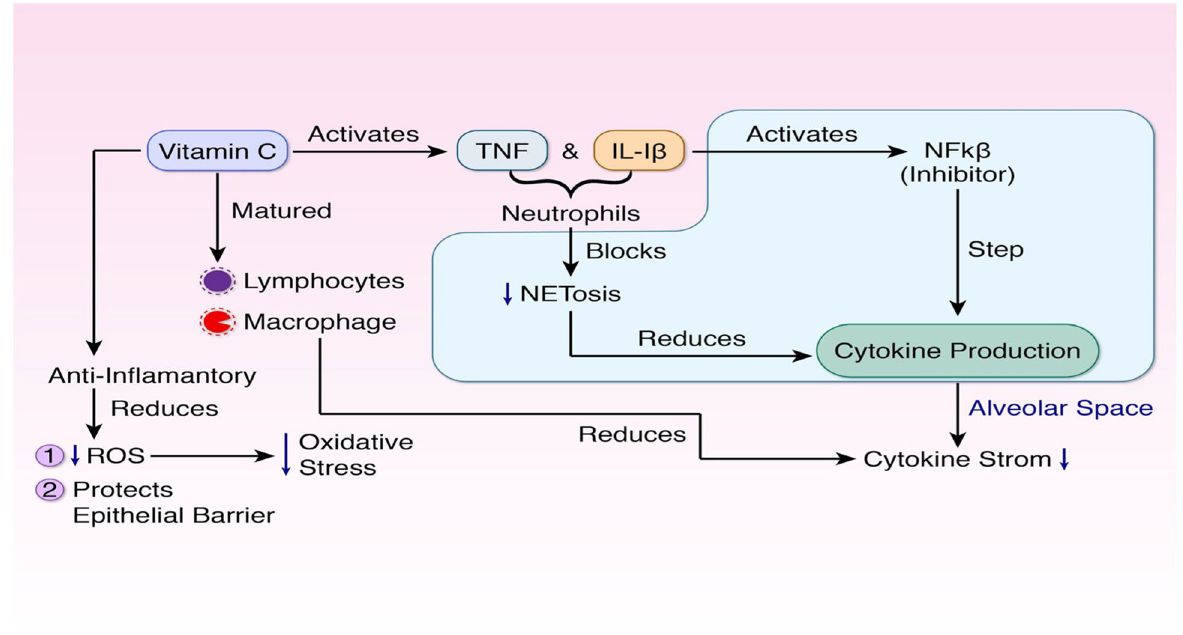
Fig. 1 Vitamin C. Its immunomodulatory activities prevent the formation of cytokine storms in two ways. a It activates neutrophils (TNF and IL-1β) which block neutrophil extracellular trap (NETosis) in the alveolar space. On the other hand, the neutrophils also inhibit nuclear transcription factor kappa B (NFkB). These two ways prevent the formation of cytokines in the body. b Vitamin C also matures lymphocytes and macrophages in the prevention of cytokine storms. Moreover, vitamin C has anti-inflammatory activities, reduces reactive oxidative species (ROS), and protects the epithelial barrier. These activities of vitamin C protect the body from diseases and also reduce the severity of